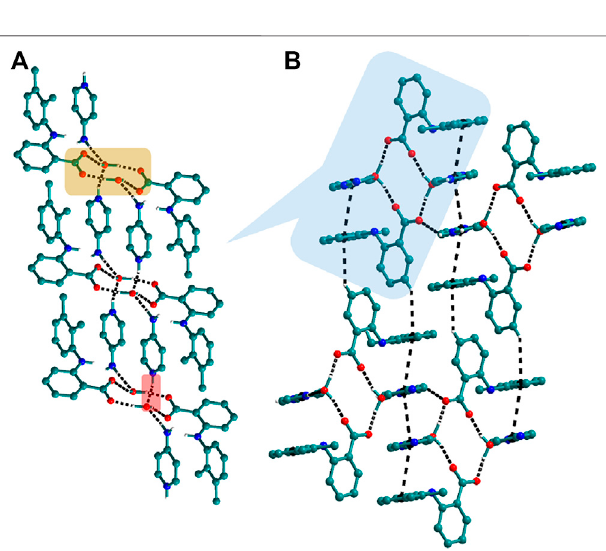
FIGURE 10 | (A) In 12 , tetramers of Mef ─ H 2 O ─ Mef are formed via synthon II which further connected through N ─ H ··· O with other tetramers forming columns. (B) These columns, interacting with others via C ─ H ··· π and π ··· π interactions, form a 3D